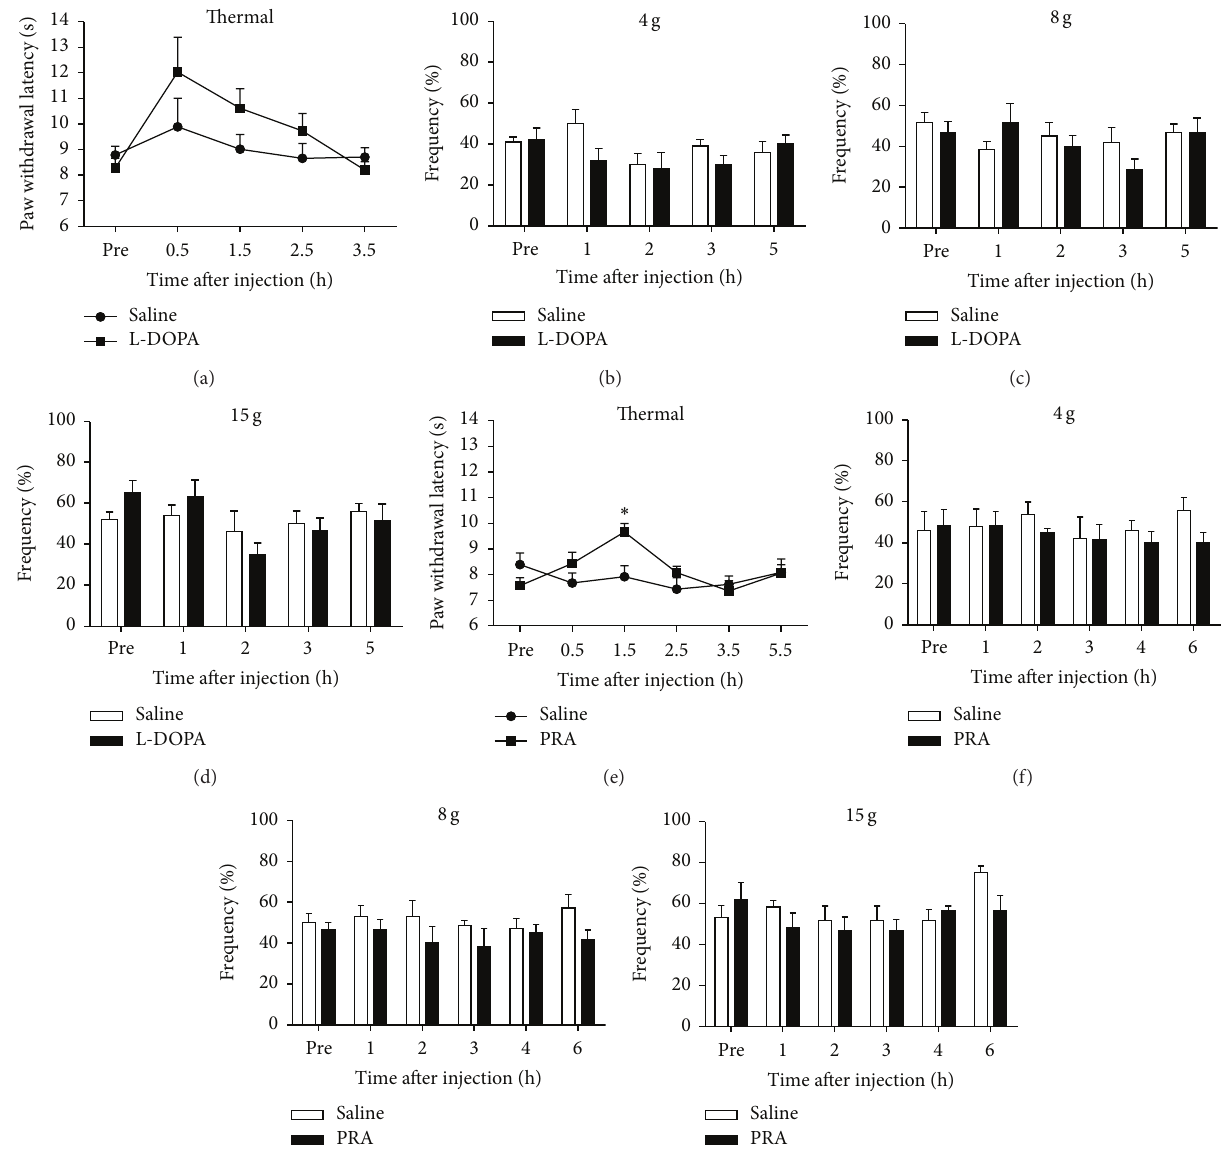
Figure 8: Effects of L-DOPA and pramipexole on thermal and mechanical hypersensitivity in 6-OHDA-lesioned rats. On the 5th week after microinjection of 6-OHDA, (a) systemic application of L-DOPA (15mg/kg, i.p.) did not significantly inhibit thermal (a) and mechanical hypersensitivity ((b)–(d)) in the 6-OHDA-lesioned rats, although there was a trend to increase the paw thermal withdrawal threshold ( 𝑛 = 5-6 for each group). ((e)–(h)) Systemic application of pramipexole (PRA; 1mg/kg, i.p.) significantly increased the paw thermal withdrawal threshold (e) after injection 1.5h, but it had no effects on mechanical hypersensitivity ((f)–(h)) in the 6-OHDA-lesioned rats ( ∗ 𝑃 < 0.05 compared to the saline control, 𝑛 = 5–7 for each